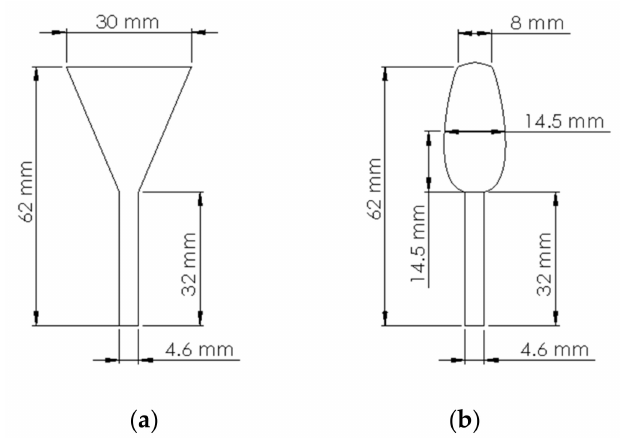
Figure 2. A scheme of a saffron flower with main sizes and shape: ( a ) including petals; ( b ) the flower